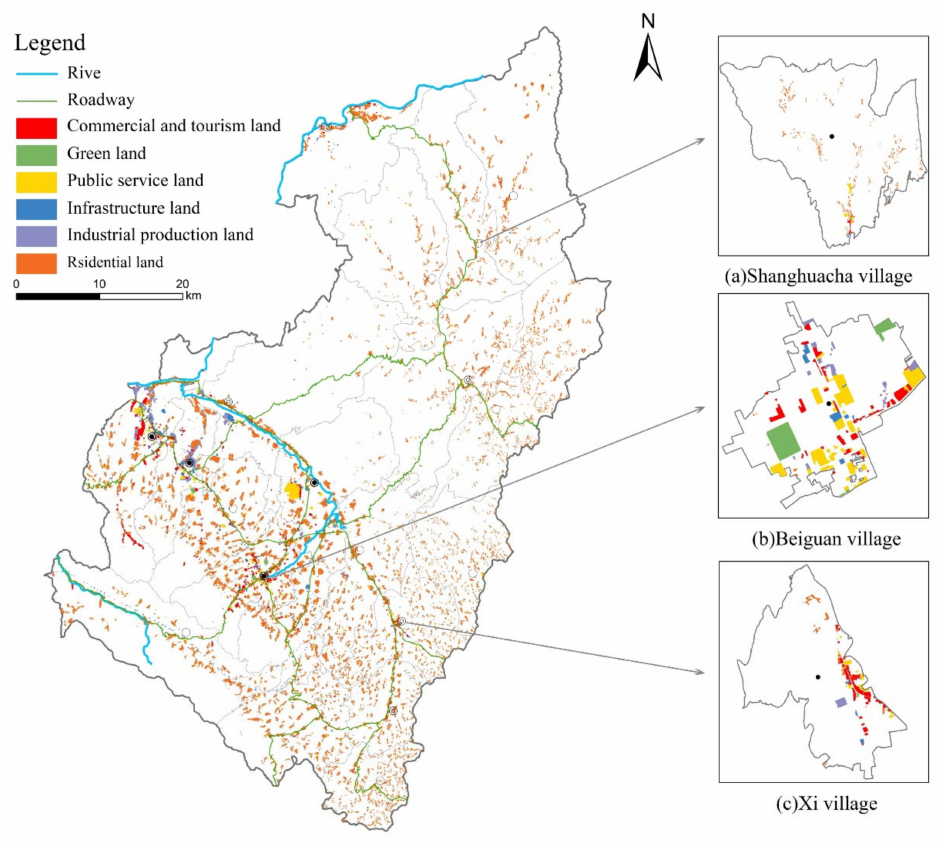
Figure 3. Distribution map of rural construction land.